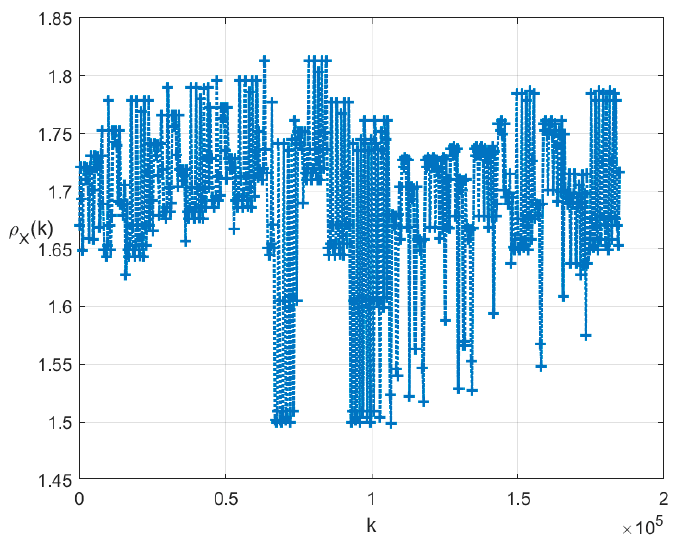
Figure 2. Indicators for k ∈ [ 1,184786 ]